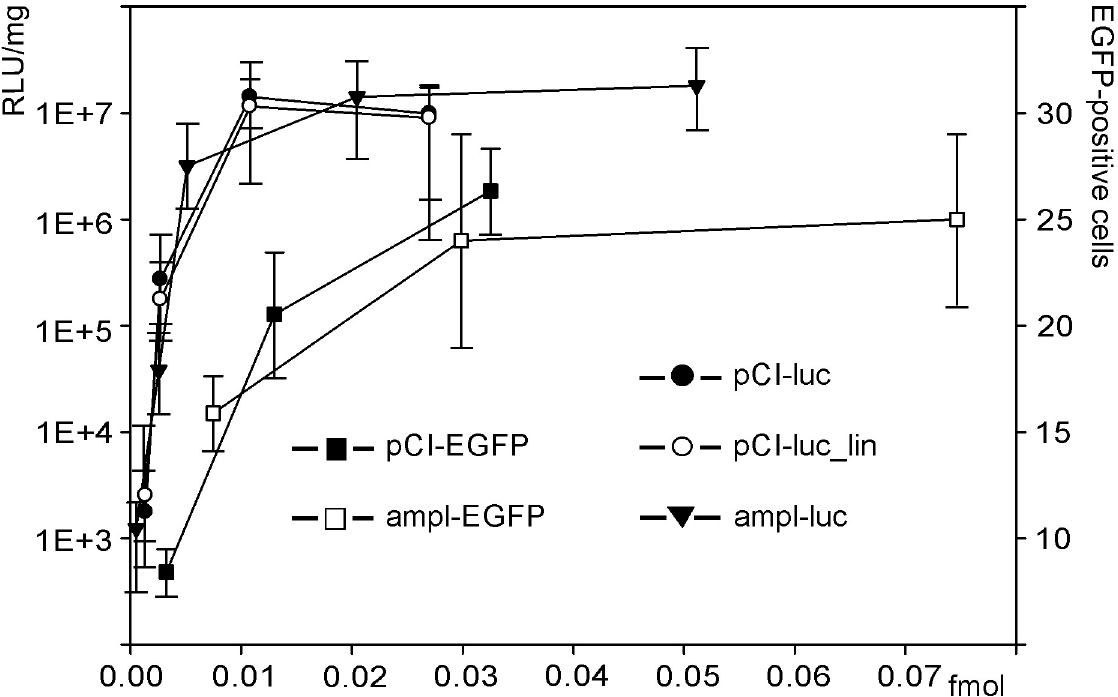
Fig 5. EGFP-positive cells and luciferase activity in cells lysates of developing D . rerio embryos. Abscissa: injected DNA quantity (femtomoles) of expression vectors pCI-EGFP, ampl-EGFP, pCI-luc, pCI-luc_lin, and ampl-luc. Ordinate, left: luciferase activity (logarithmic scale) normalized to total protein detected in lysates of D . rerio embryos 72 h after injection. Ordinate, right: the number of EGFP-positive cells per embryo 48 h after injection. The one-way ANOVA with Tukey’s correction for multiple comparisons was used